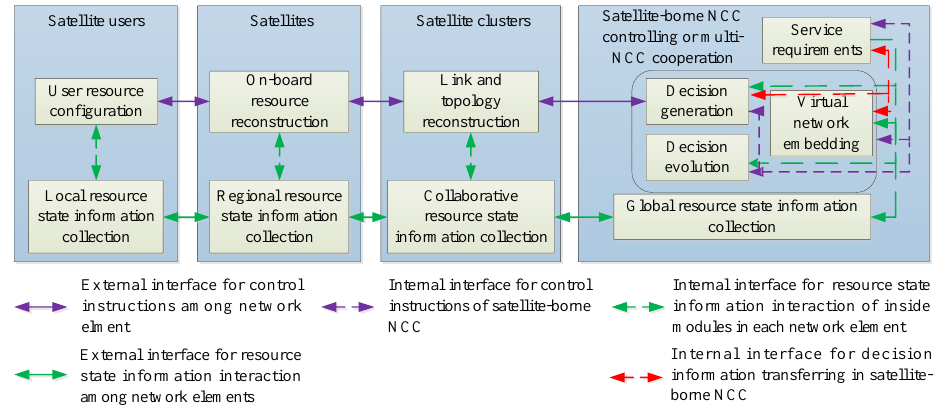
Figure 2. A hybrid resource management architecture for